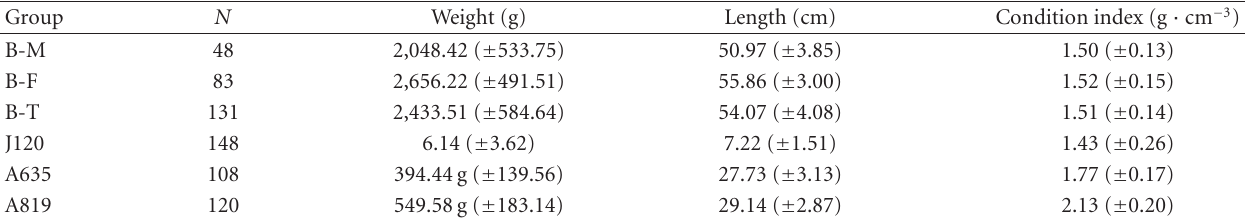
Table 3: Means (standard deviation) for body weight, fork length, and condition index in samples